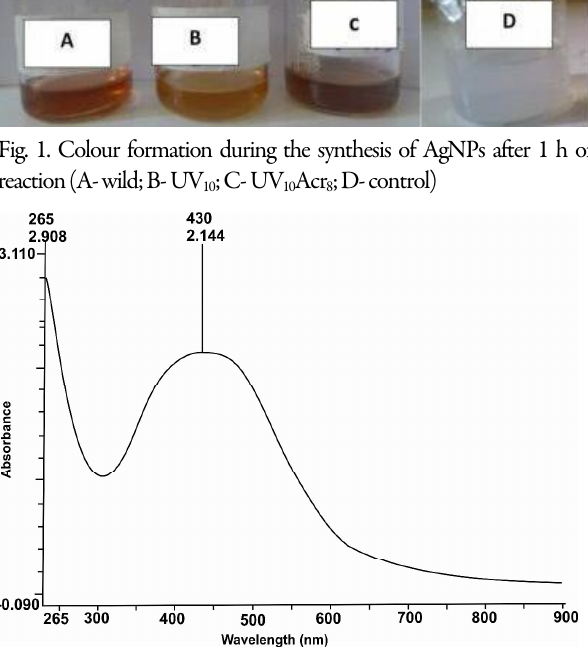
Fig. 2. UV-Vis absorption spectrum of the biosynthesized AgNPs using laccase of UV strain of L. 10